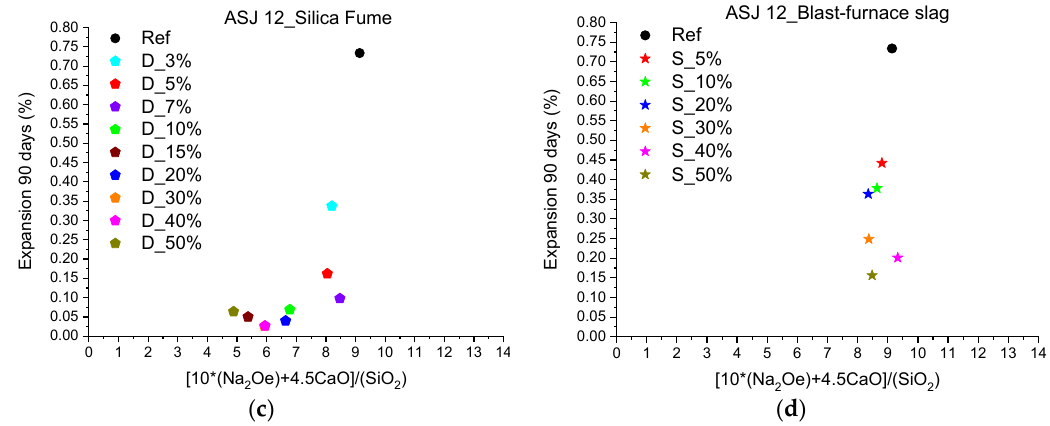
Figure 11. Relation between ([10·(Na2Oeq) + 4.45·CaO]/SiO2) and expansion of mortars made with the high-reactive siliceous pebble, ASJ_12, and four additions mixed in different percentages after 90 days of testing: ( a ) natural pozzolan, P; ( b ) siliceous coal fly ash, V; ( c ) silica fume, D; ( d ) blast-furnace slag, S.